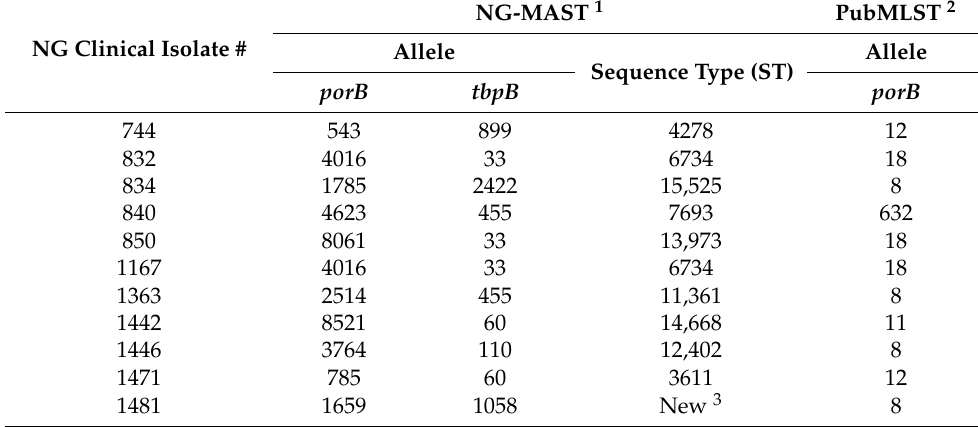
Table 1. Molecular characteristics of N. gonorrhoeae clinical isolates.